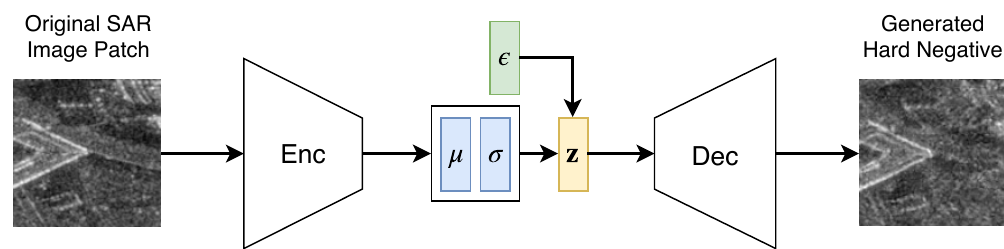
Figure 4. The inference network used to generate hard negative samples. The latent code z used to generate patches is created by sampling the latent distribution near to the original image. To keep the network end-to-end differentiable, this sampling is done via a re-parameterization trick using (cid:101) ∼ N ( 1, 0 ) to add randomness.